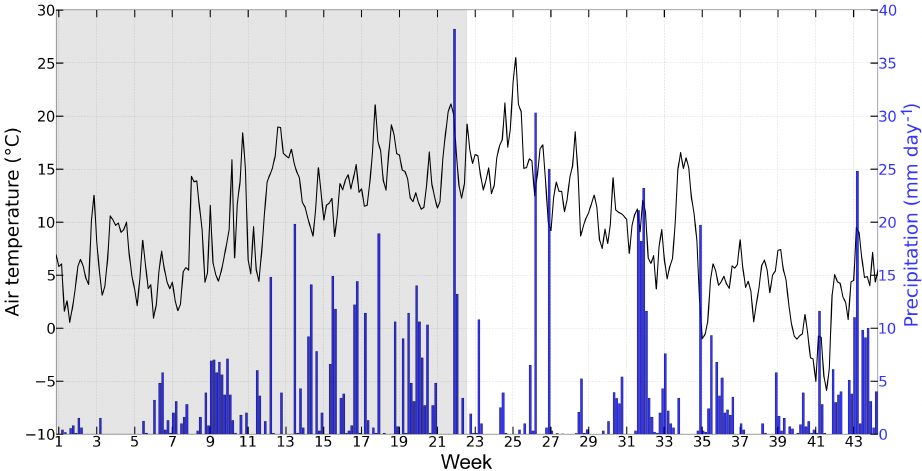
Figure 2. Historical records of daily mean air temperature (solid black line; left y -axis) and precipitation (blue bars; right y -axis) in the period from 1 March to 31 December 2012 for the Rollesbroich experimental test site in the Eifel mountain range in western Germany. The grey region demarcates the 5-month assimilation period (1 March to 31 July 2012) which is used for VIC-3L and CLM calibration using joint parameter and state estimation. The subsequent 5-month period between 1 August and 31 December 2012 serves as our evaluation period to verify the performance of the calibrated VIC-3L and CLM models without state estimation.